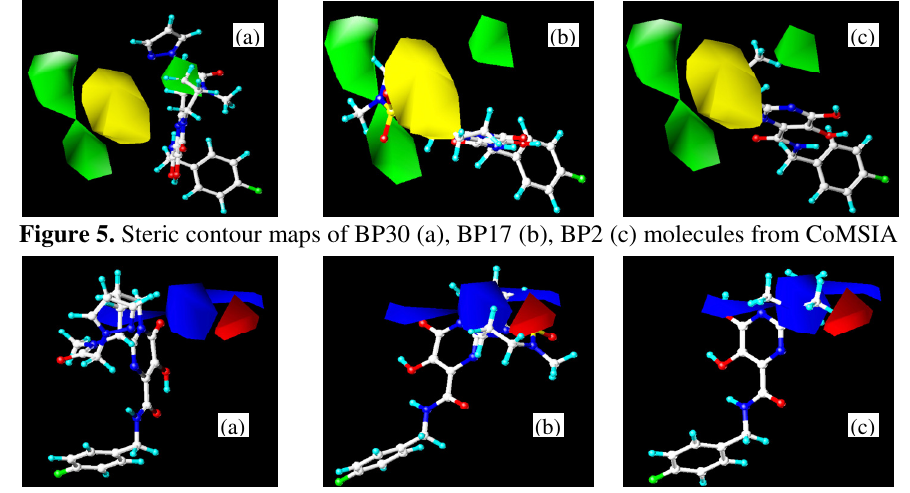
Figure 6. Electrostatic contour maps of BP30 (a), BP17 (b), BP2 (c) molecules from